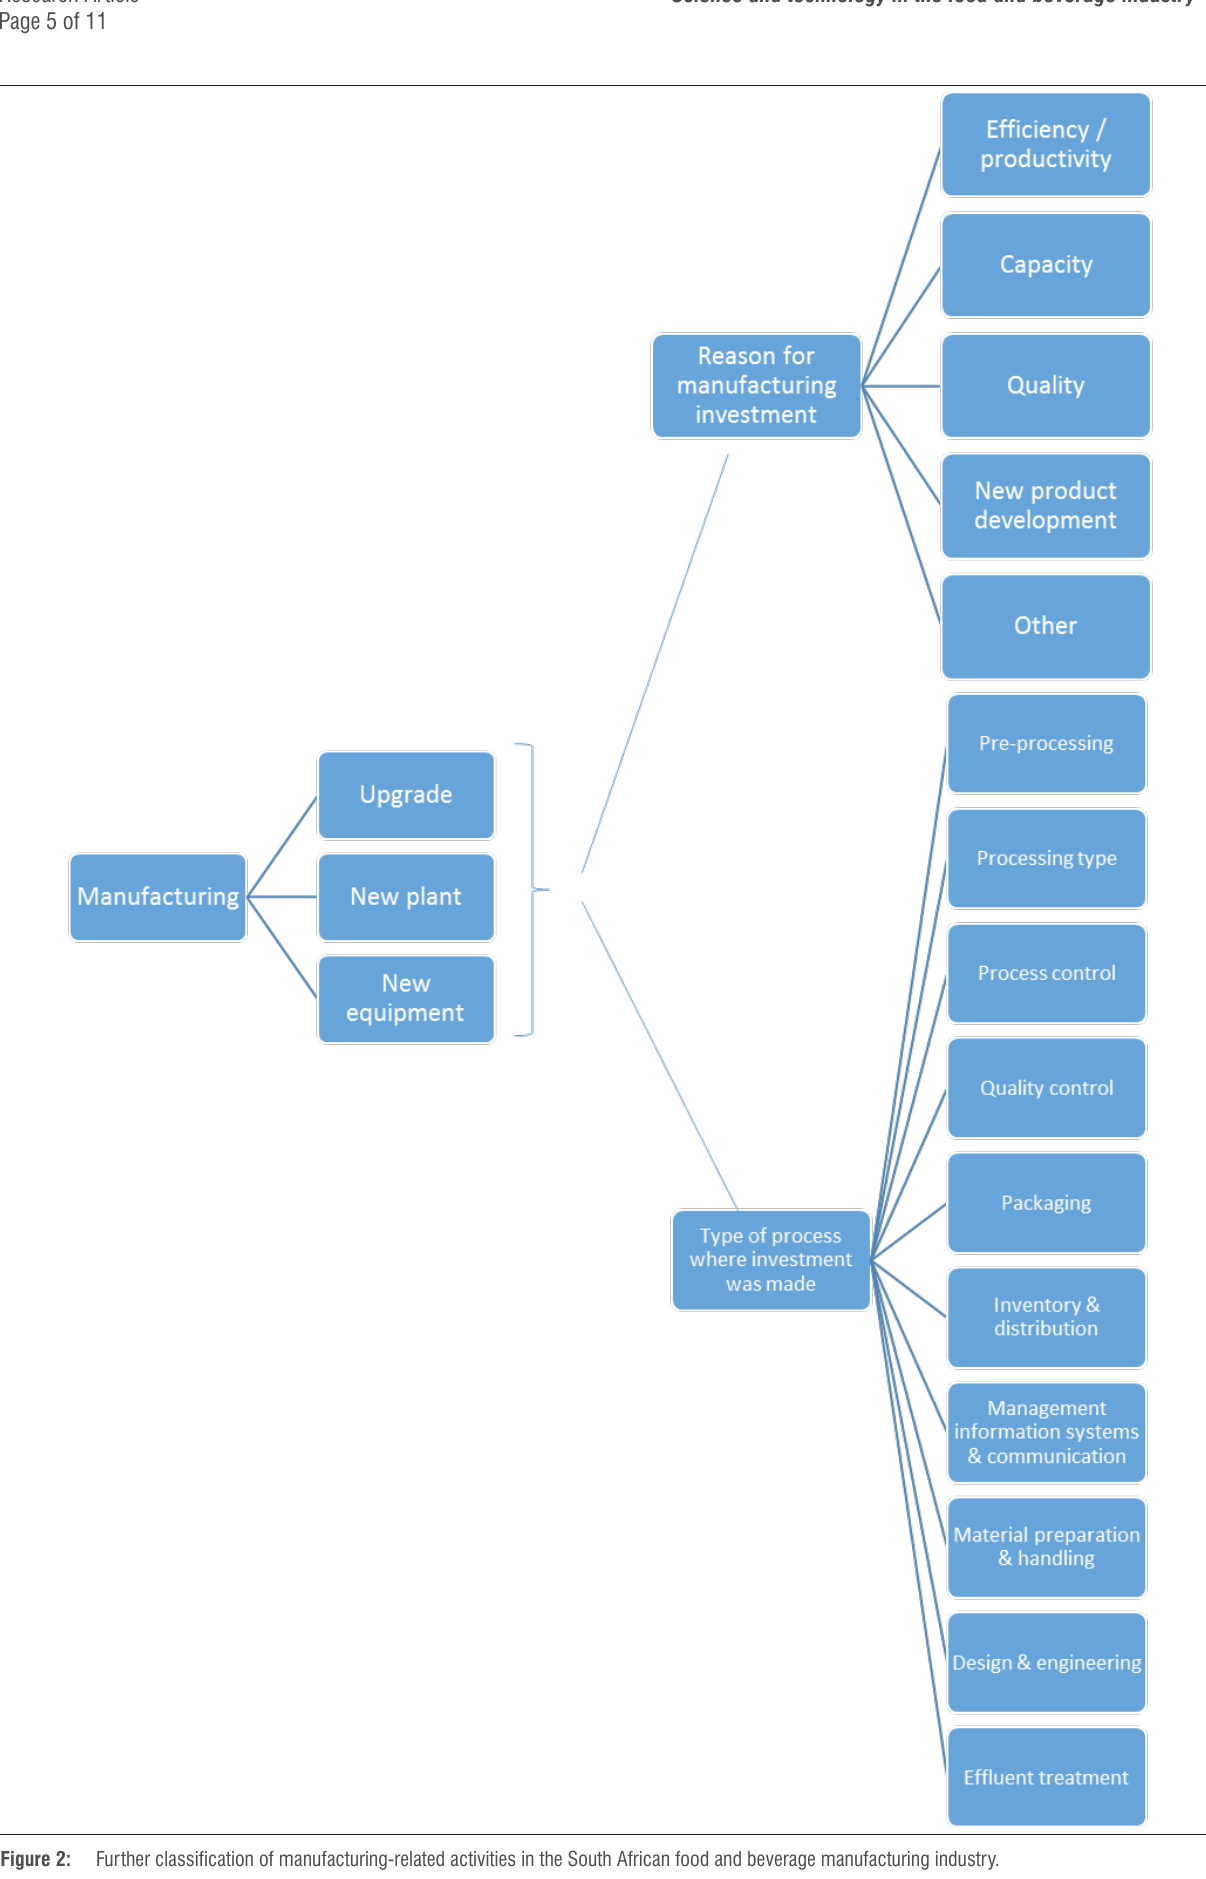
5 South African Journal of Science